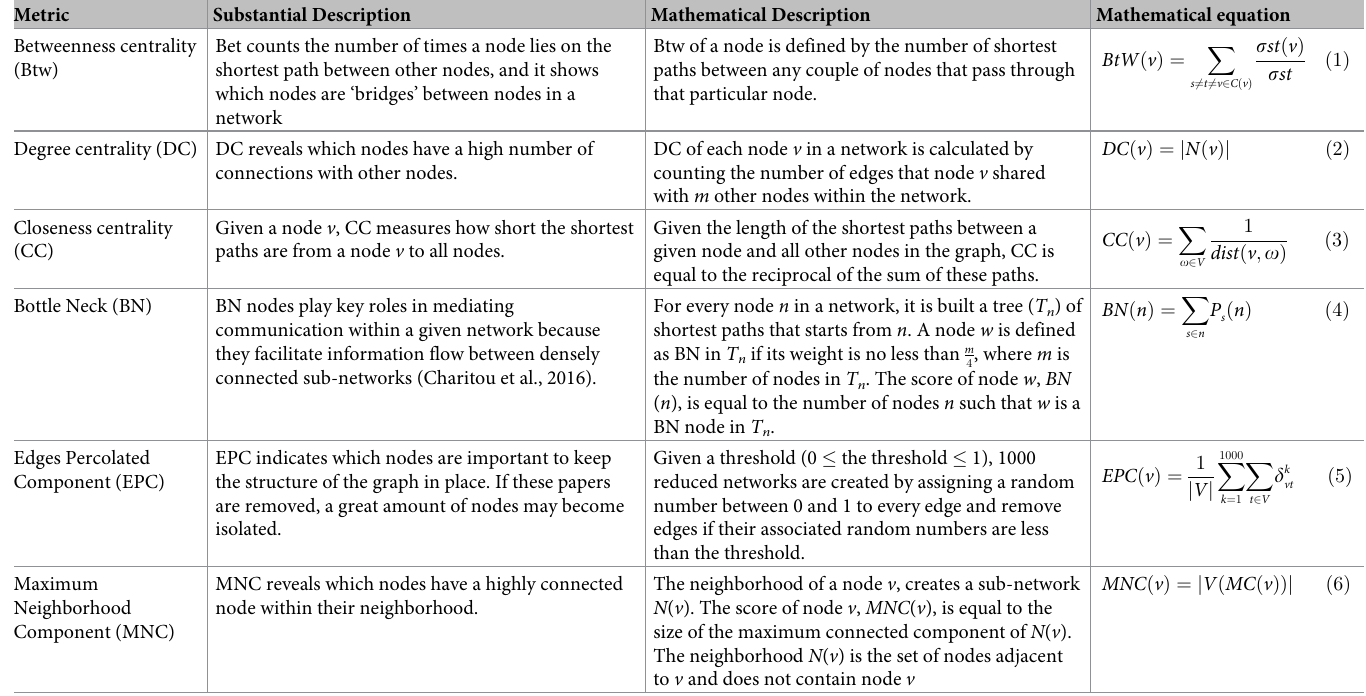
Table 1. Metrics. In addition to the metrics reported in this Table, the Density Maximum Neighborhood Component (DMNC) metric, which detects densely connected neighborhoods, was calculated. However, DMNC was not taken into account for further analysis (see Section D in S1 File). Metric Substantial Description Mathematical Description Mathematical